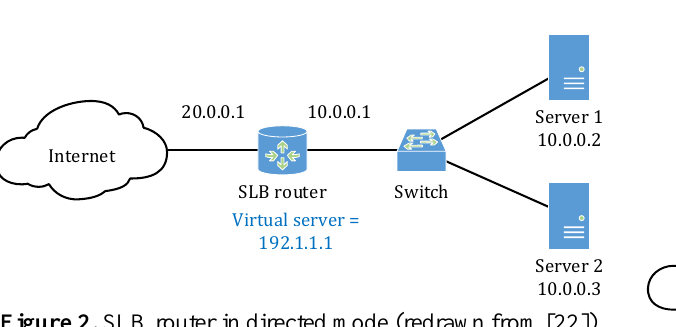
Figure 2. SLB router in directed mode (redrawn from [22])